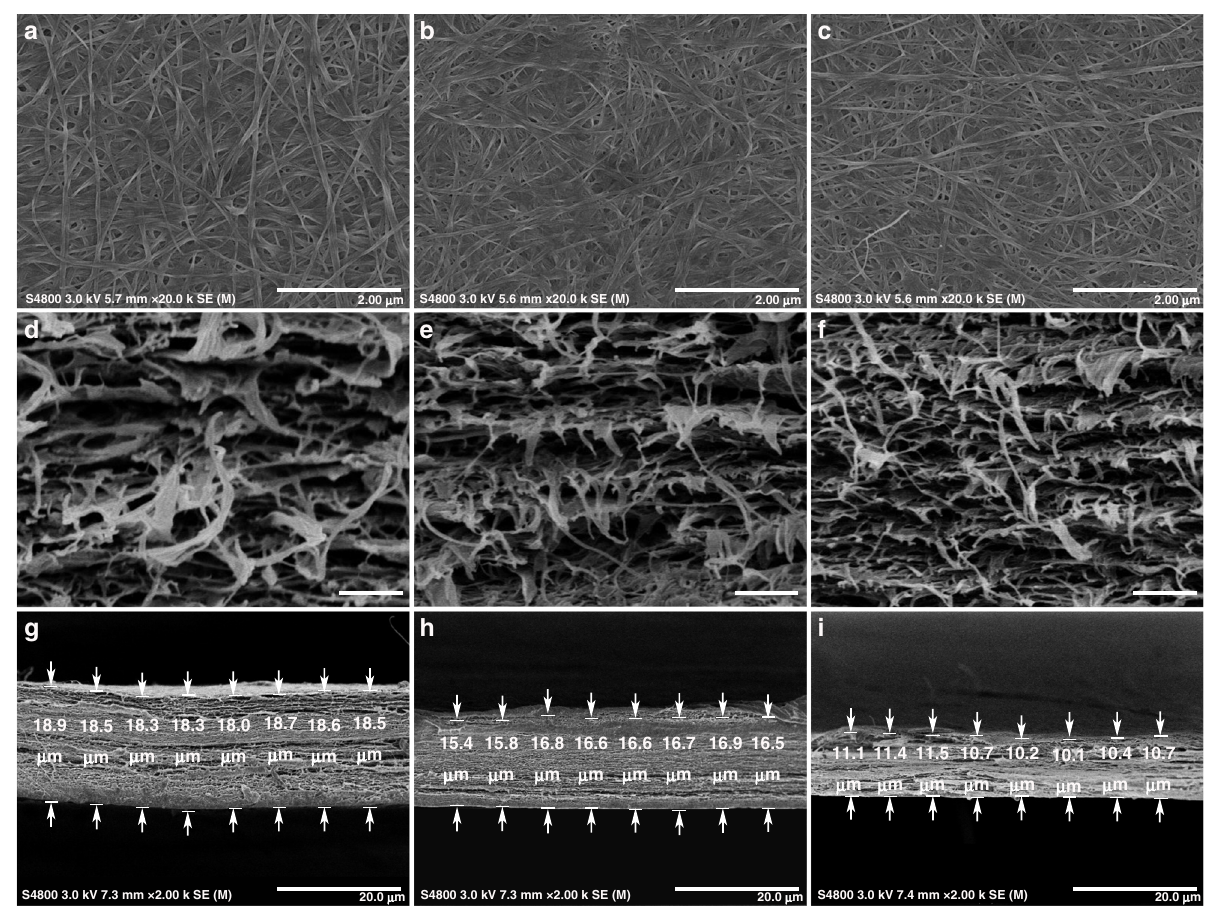
Fig. 5 Microstructure observation of BC through SEM. a – c Top view of different BC samples. The diameters of different BC fi bers showed no signi fi cant differences, whereas the pore sizes of a HC-6CF-BC and b LC-6CF-BC were slightly larger than that of c BC. The scale bar corresponds to 2 μ m. d – i Cross- section of different BC samples. The gaps of d HC-6CF-BC were signi fi cantly larger than those of e LC-6CF-BC and f BC samples. Moreover, g HC-6CF-BC was also thicker than h LC-6CF-BC and i BC samples. d – f , The scale bar corresponds to 400 nm. g – i , The scale bar corresponds to 20 μ